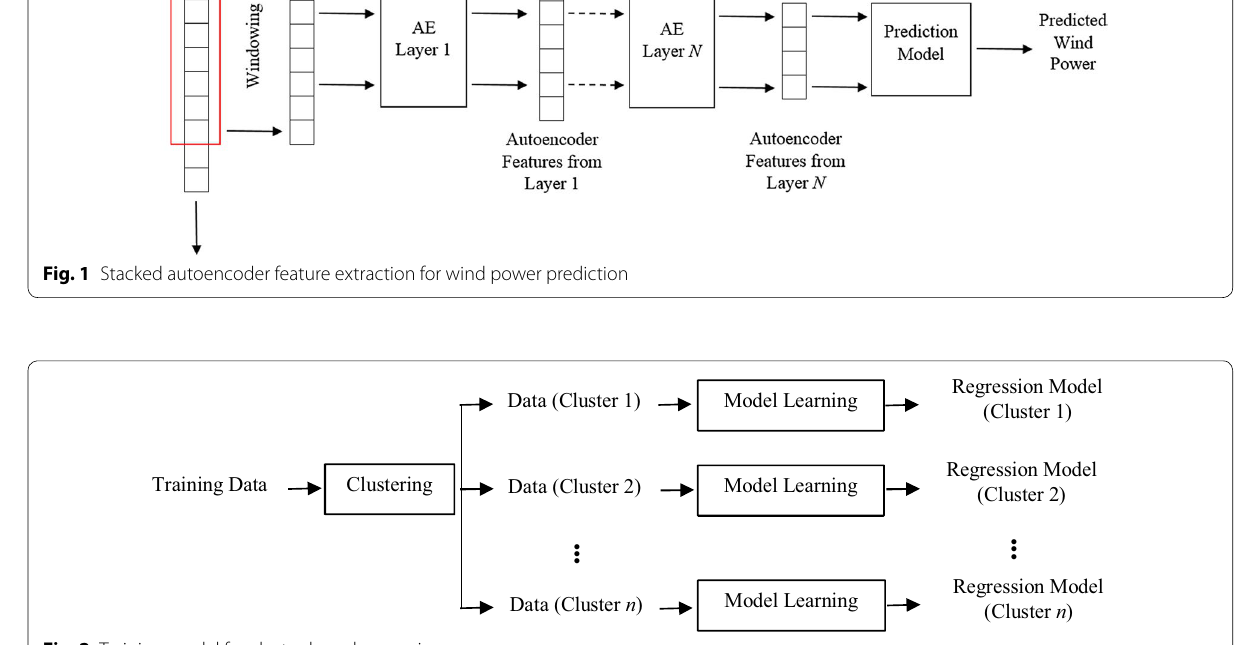
Fig. 2 Training model for cluster-based